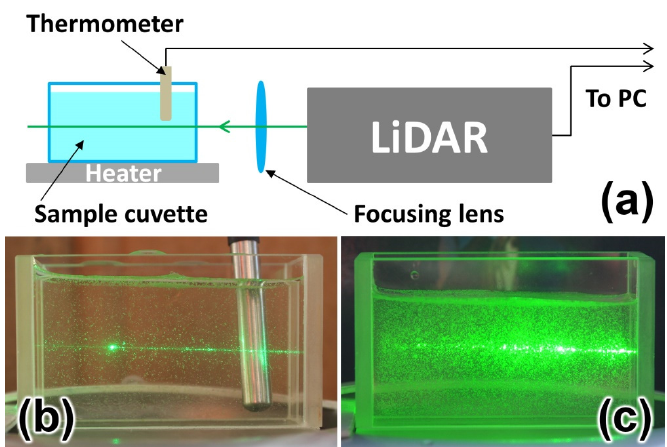
Figure 9. Experimental scheme of water temperature measurements by LiDAR ( a ); photograph of the cuvette with a sample having 420 cells/mL algae concentration ( b ); photograph of the cuvette with a sample having 10,800 cells/mL algae concentration ( c ).